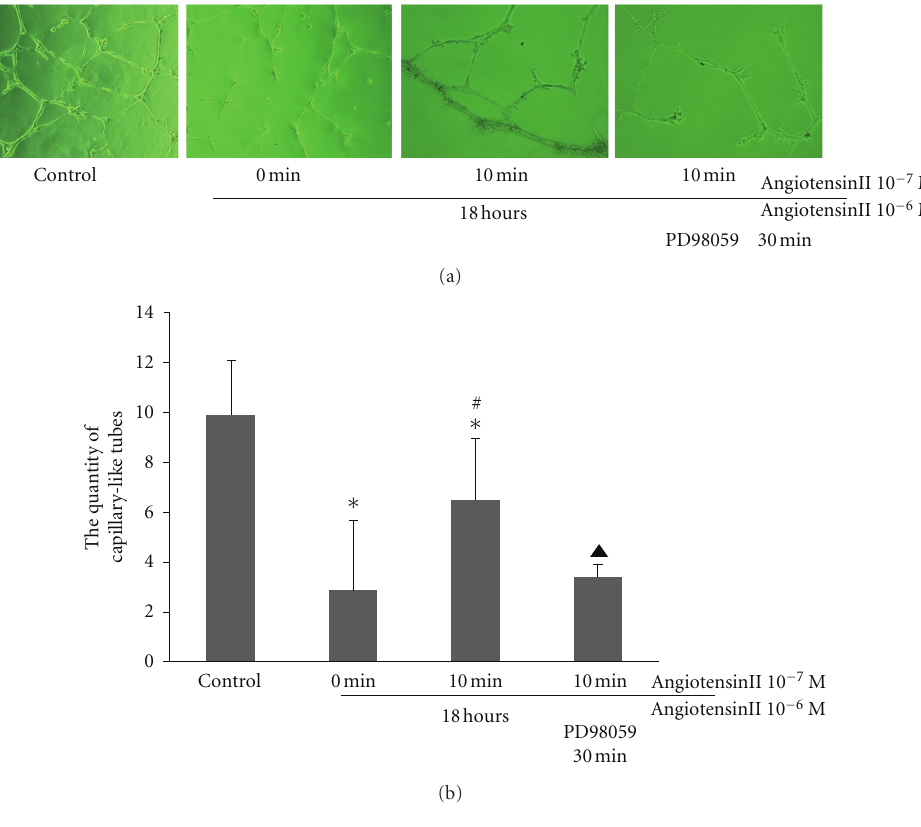
Figure 4: E ff ects of ERKs inhibition on AngII preconditioning-induced improvement of vasculature formation under the condition of AngII stimulation. CMVECs preincubated with or without PD98059 (50 μ M) for 30min were treated with 10 − 7 M AngII for the indicated times, and then the cells were seeded onto the matrigel in plates containing AngII (10 − 6 M) or not (control). Eighteen hrs later, the formation of capillary-like tubes was observed under an optical microscope. (a) Representative photomicrographs of capillary-like tubes (100xmagnification). (b) Quantitative analysis for capillary-like tube formation. Capillary-like tubes were counted in randomly selected 5 fields for each plate. Data represent mean ± SD obtained from 12 independent experiments ( n = 12). ∗ P < 0 . 05 versus control group; # P < 0 . 05 versus the group without AngII pretreatment (0min); (cid:2) P < 0 . 05 versus the group pretreated with AngII (10min) but without